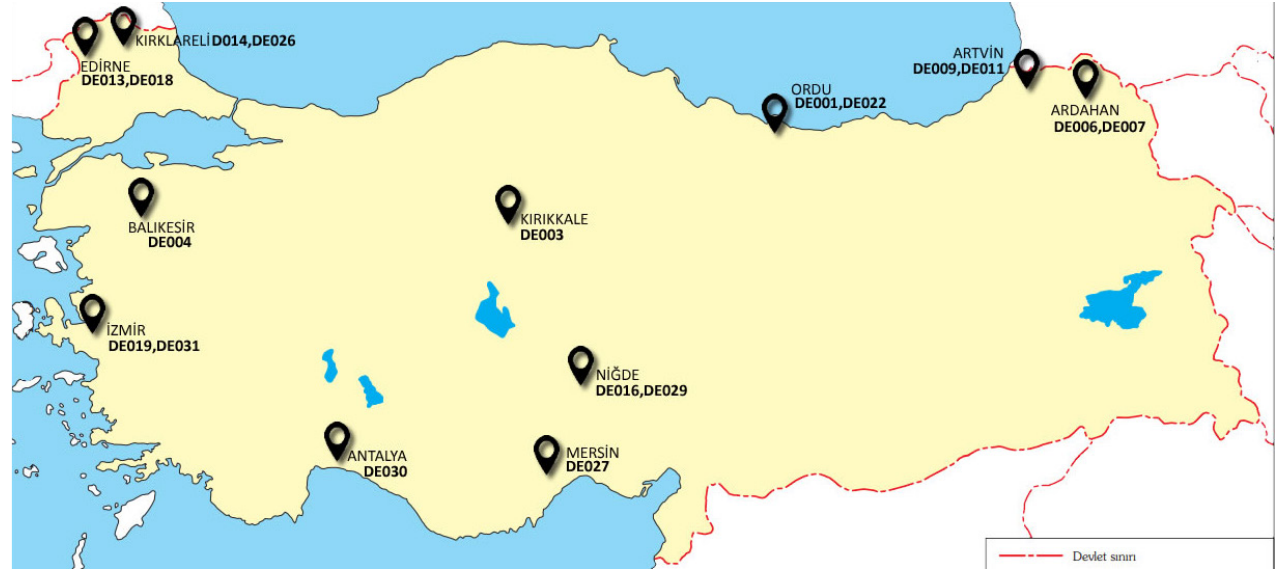
Fig 1. The locality of dead honey bees collected from different provinces of Turkey Province name, isolate